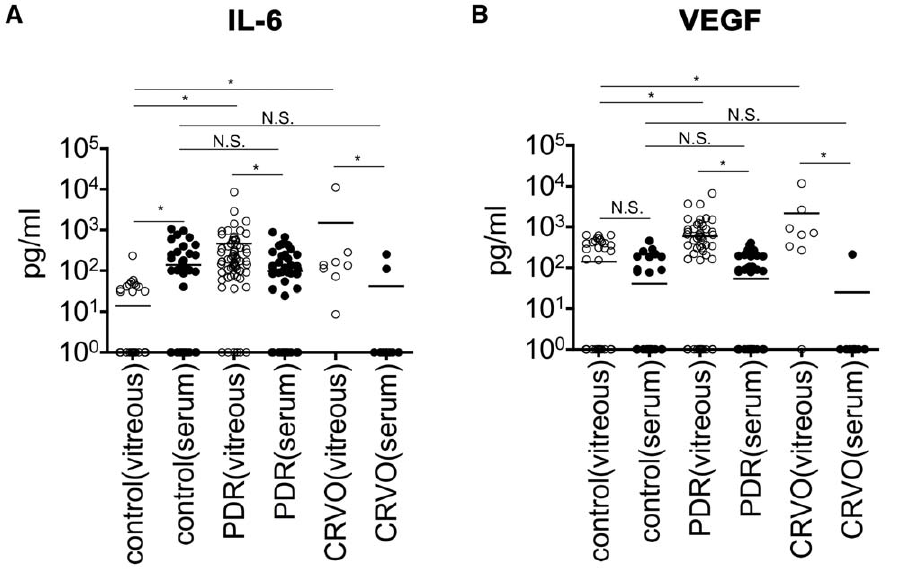
Figure 5. Serum IL-6 and VEGF concentrations are not significantly related with vitreous concentrations. Shown are comparison of (A) IL-6, and (B) VEGF levels in vitreous and in serum of patients with control (n=53), PDR (n=66) and CRVO (n=8). The ordinate showed the concentrations of soluble factors in the log scale, bars represent the mean value of each group. Bars represent the mean value of each group. * P , 0.01, N.S.: not significant.